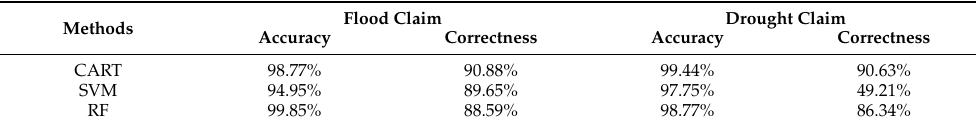
Table 12. Comparison of CART with SVM and RF on Sentinel-1 SAR GRD